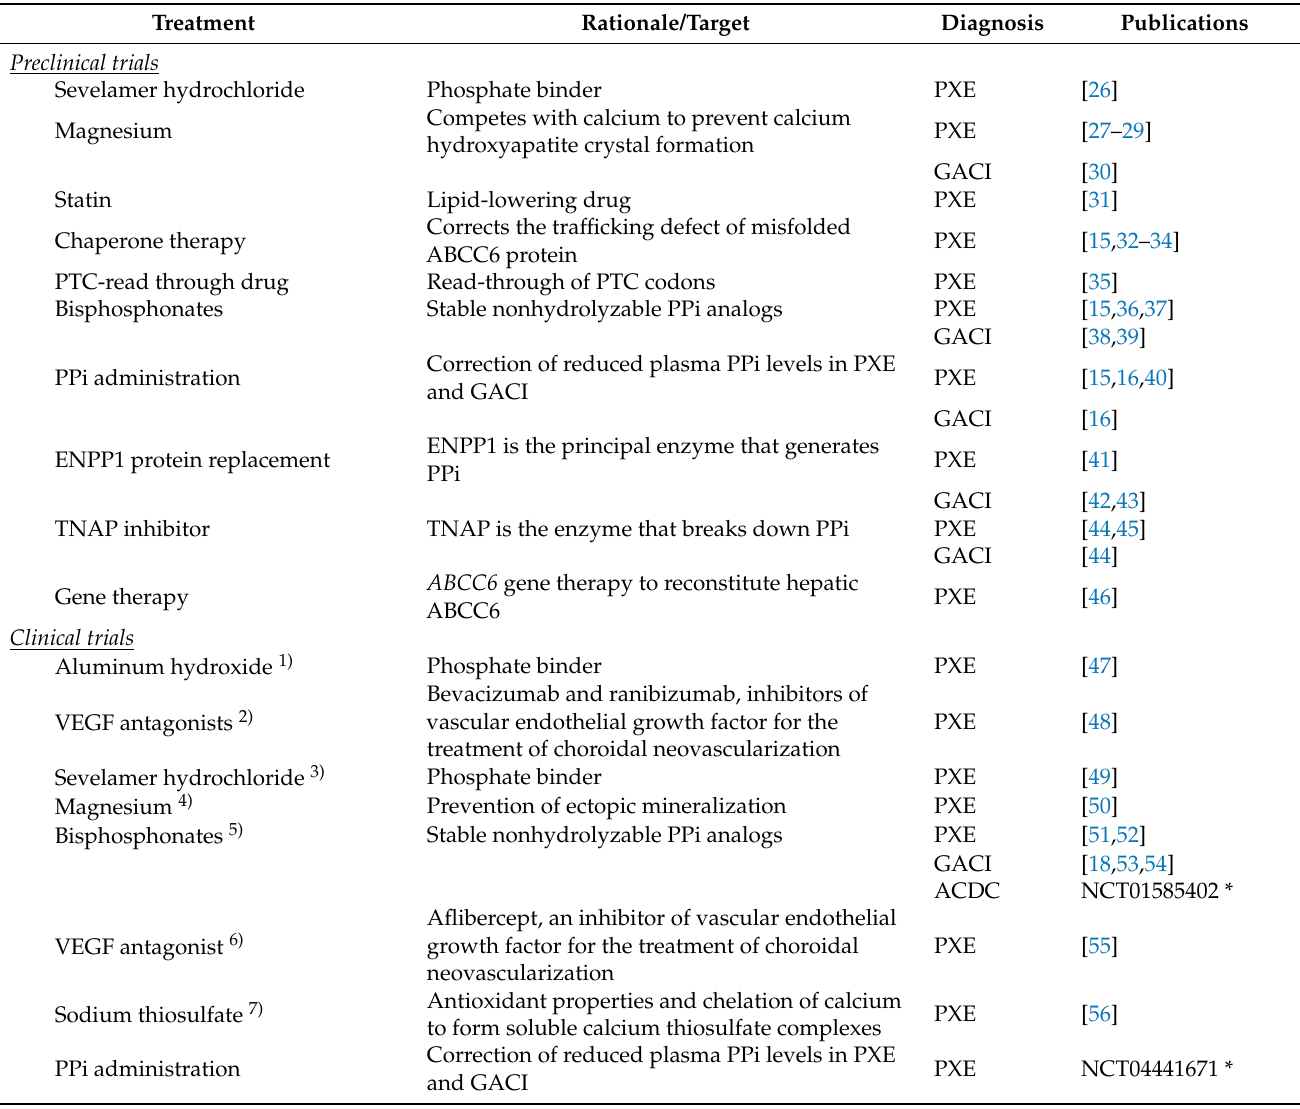
Table 2. Interventional preclinical studies and early clinical trials for PXE, GACI, and ACDC, published and